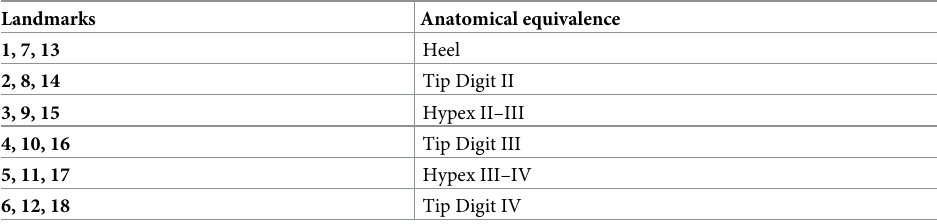
Table 2. Landmark description.